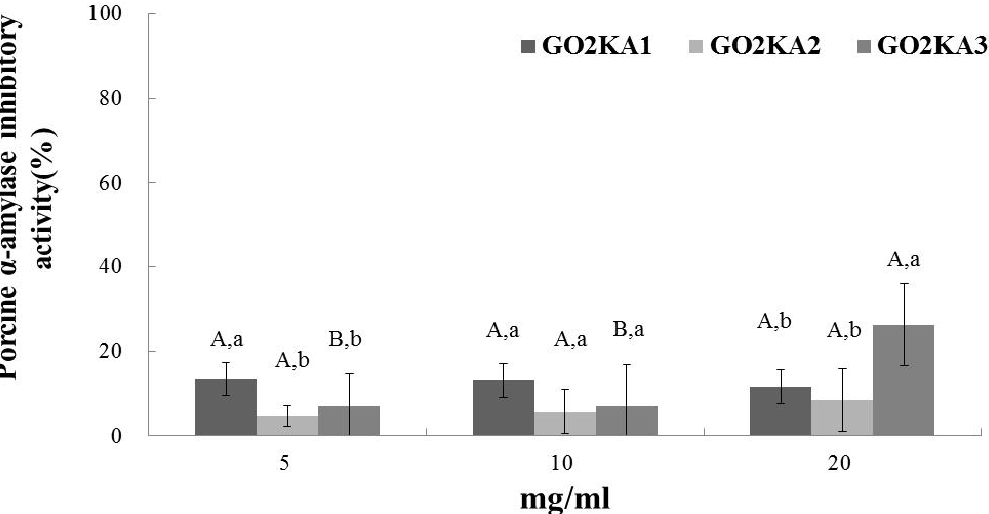
Figure 2. Dose dependent changes in porcine pancreas α -amylase inhibitory activity (% inhibition) of chitosan oligosaccharides classified by molecular weight (GO2KA1; MW < 1000 Da, GO2KA2; MW 1000–10,000 Da, GO2KA3; MW > 10,000 Da). The results represent the mean ± S.D. of values obtained from three measurements. Different corresponding letters indicate significant differences at p < 0.05 by Duncan’s test. A − C First letter is among different samples and a − c second one is among different concentrations within same